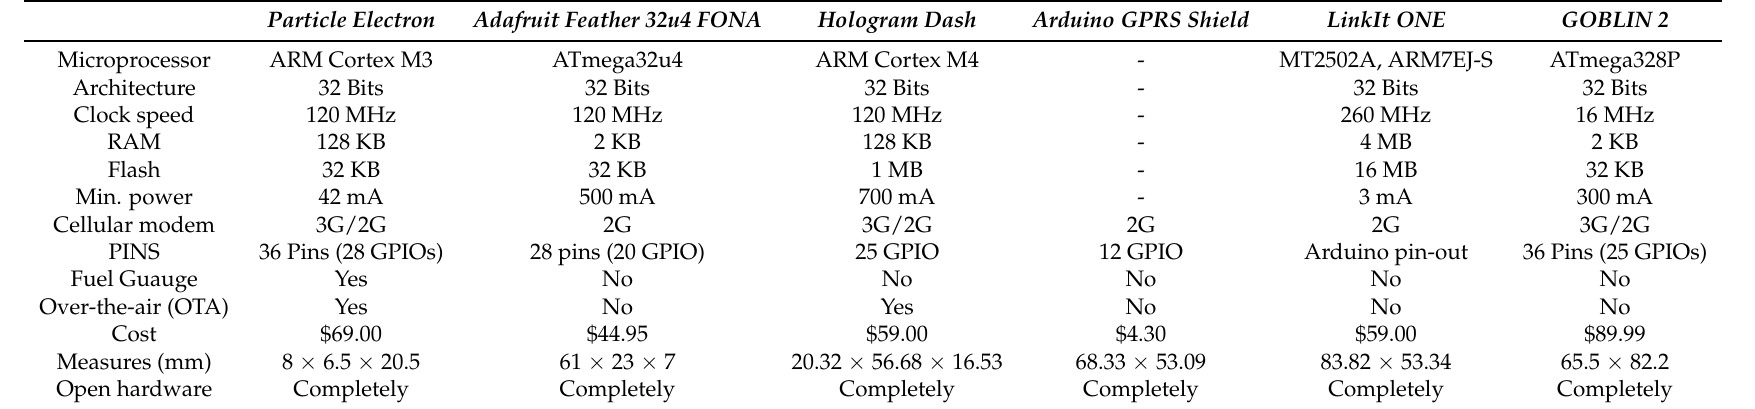
Table 1. Comparison between different open-hardware microcontroller-based platforms with 3G